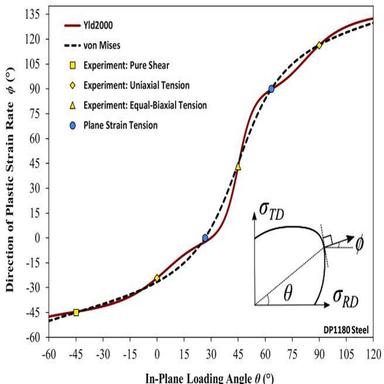
Directions of the predicted plastic strain rate using the von Mises and Yld2000 yield functions in the RD-TD plane.